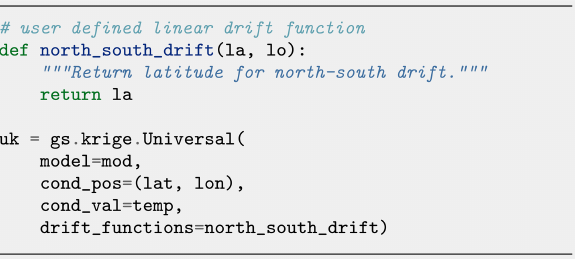
Figure 18. Setting up universal kriging with a drift function. Figure 19. Workflow for regression kriging with a linear regression